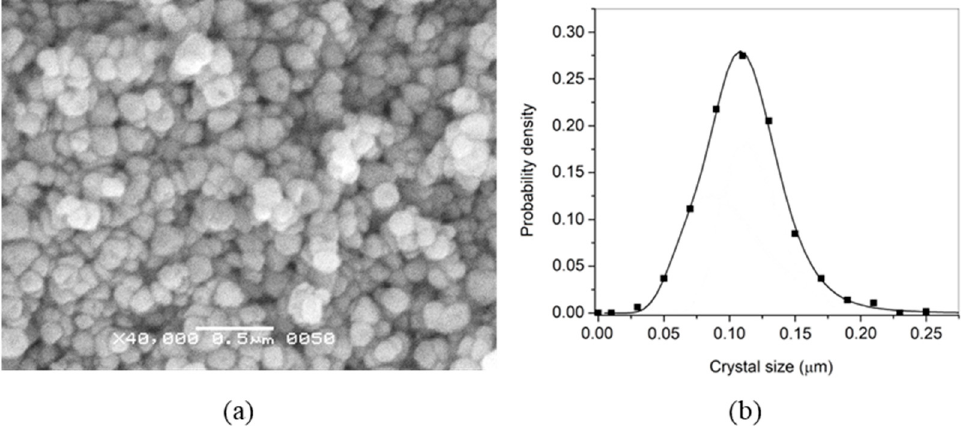
Figure 2. SEM image ( a ) and particle size distribution ( b ) of BaTiO 3 powder synthesized at 200 °C, 1.55 MPa over 20 h. in water vapor.